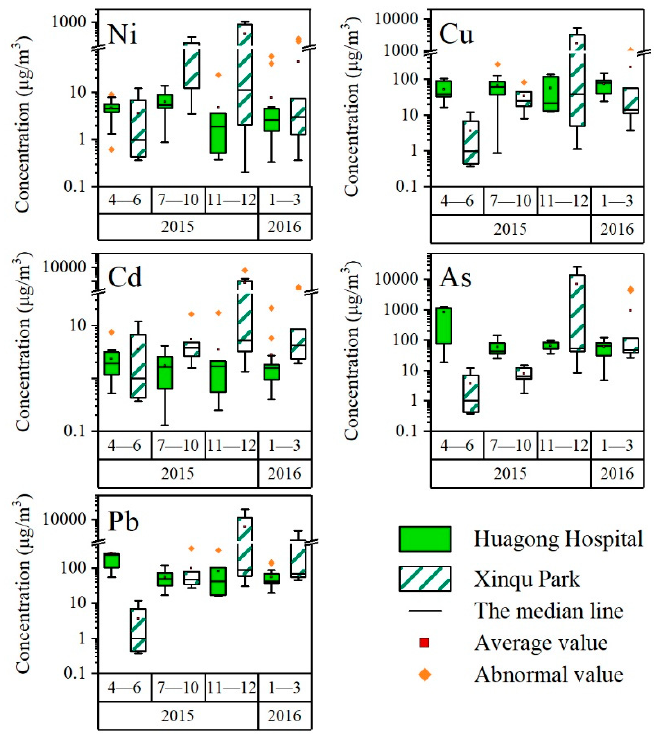
Figure 2. Heavy metal concentrations of PM 2.5 in Huagong Hospital and Xinqu Park. Note: ( a ) rep- resents April to June; ( b ) represents July to September; ( c ) represents October to December; ( d ) rep- resents January to March.